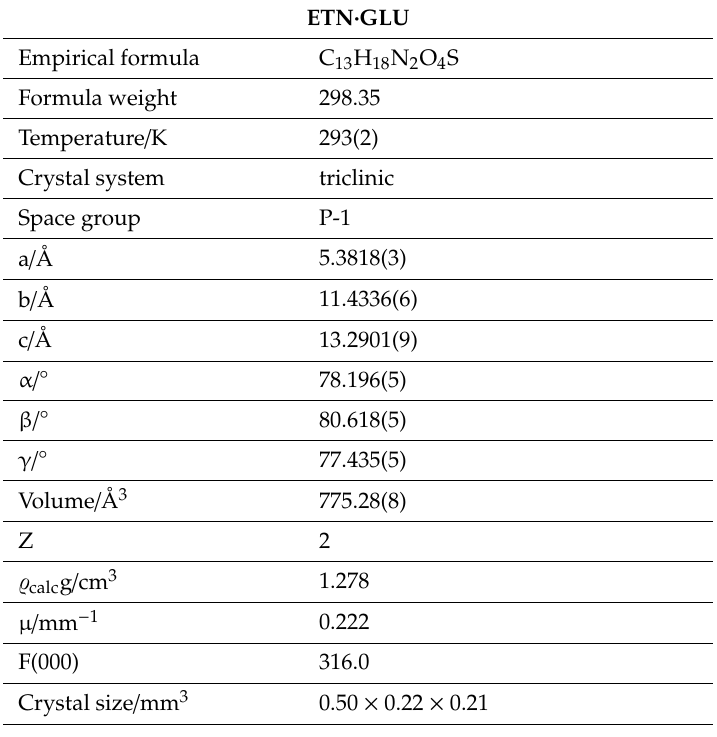
Table 1. Crystal data and structure refinement parameters for ETN · GLU, ETN · MAL and ETN ·